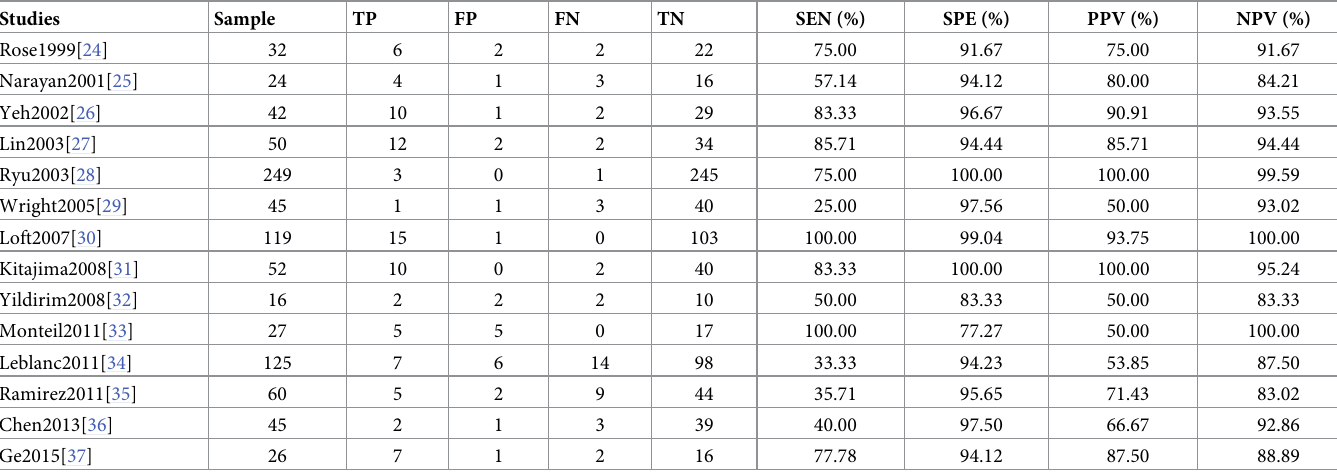
Table 1. The general characteristics of the included studies.